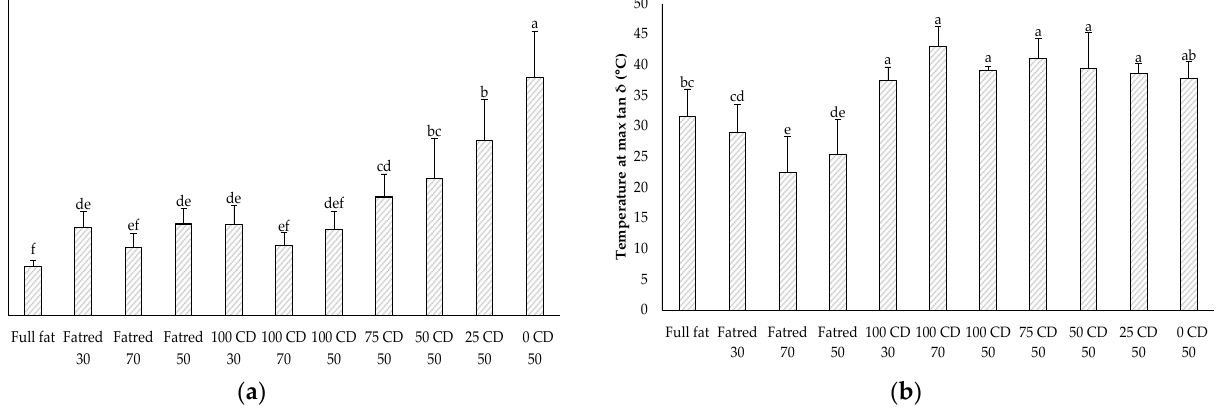
Figure 5. Maximum loss tangent (tan δ) ( a ) and temperature at the maximum loss tangent ( b ) of the PCS samples determined with a temperature sweep. The data are expressed as mean ± standard deviation ( n > 9). Bars with different letters indicate significant differences between samples ( p ≤ 0.05) following a one-way ANOVA (Tukey).